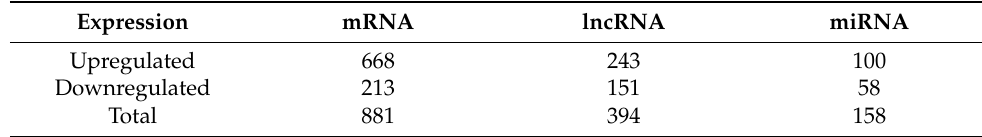
Table 2. Differentially expressed mRNAs, miRNAs, and lncRNAs between low and high intramuscu- lar fat in crossbred pigs (Berkshire × AQSW).